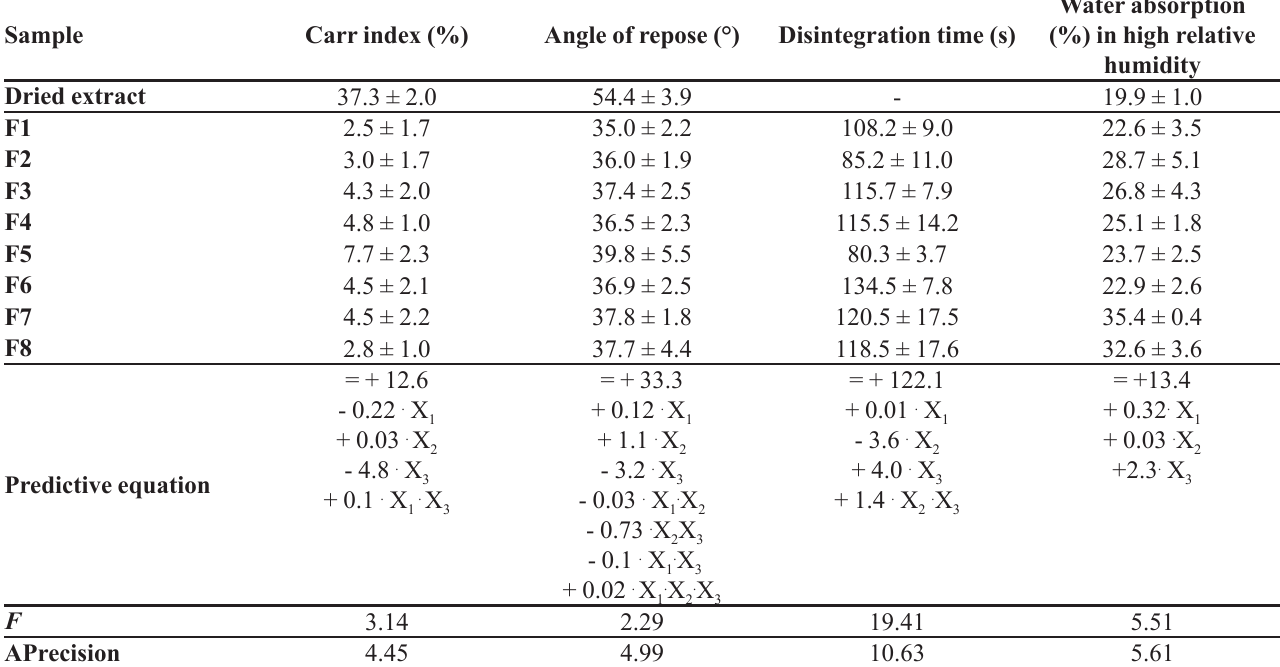
TABLE III - Physical and mechanical properties of the dried extract of Maytenus ilicifolia and its effervescent granules with the corresponding predictive equation together with the validation parameters of the model